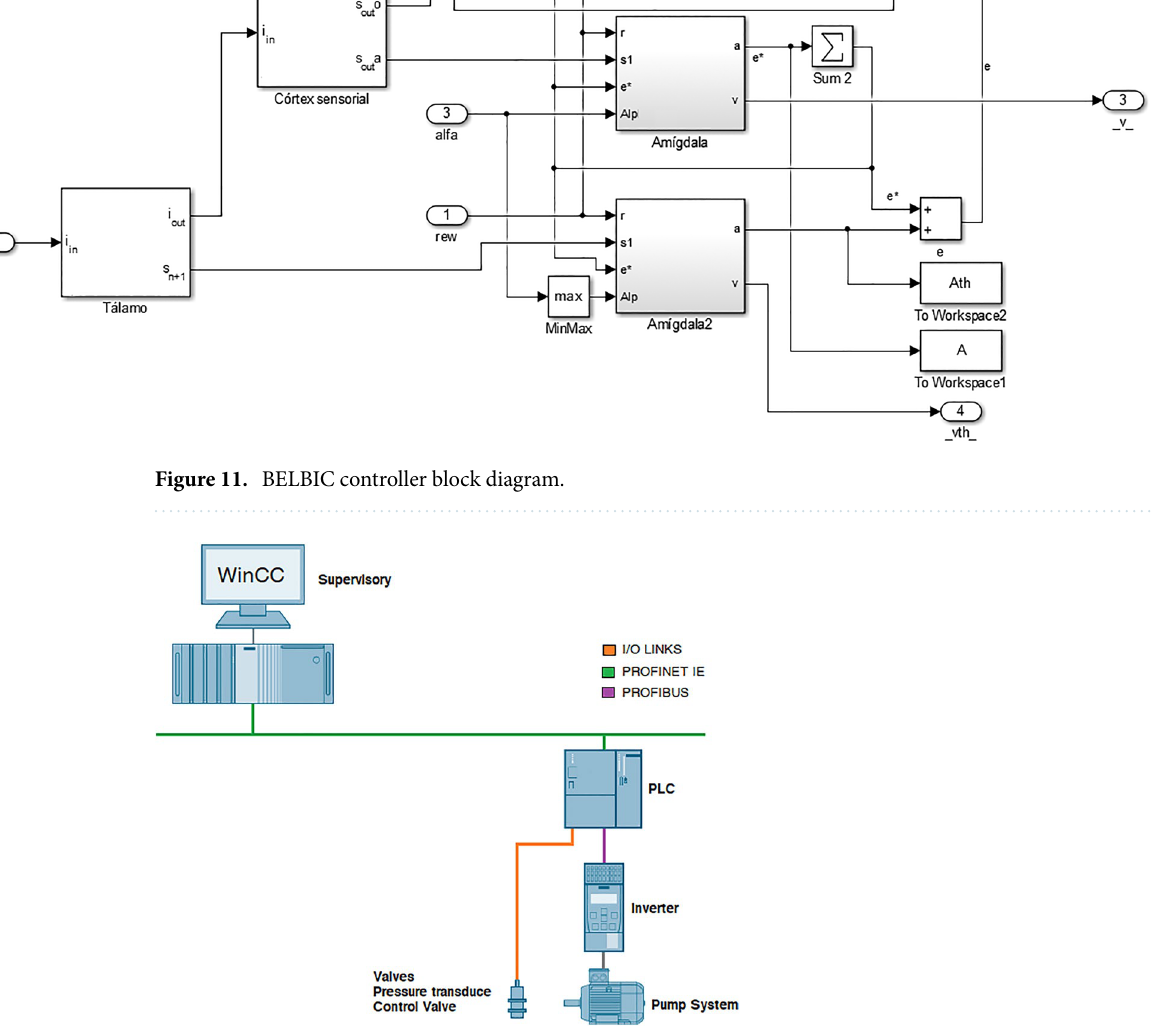
Figure 12. Pump bench topology—created using paint software version